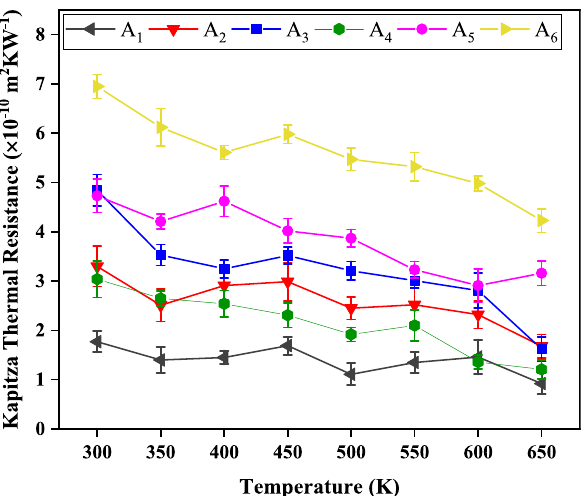
Figure 7. The changes in Kapitza thermal resistance of six constructed grain boundaries A 1 (5–7–6–6–s), A